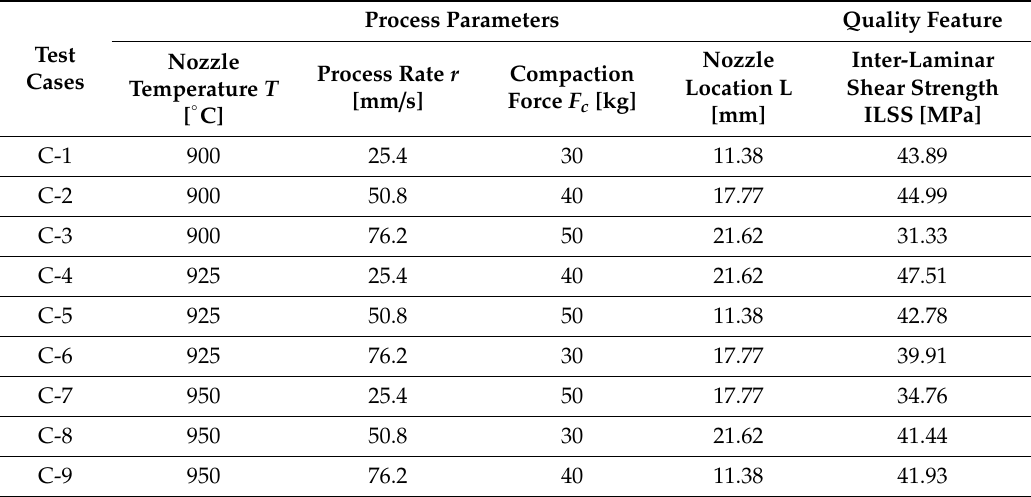
Table 3. Experimental results for the Automated Fiber Placement (AFP) process [53].